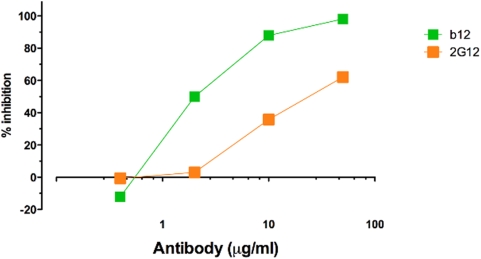
Comparison of antibody-dependent cell-mediated viral inhibition (ADCVI) by 2G12 and b12.Target cells (CEM.NKR-CCR5) were infected with SHIVSF162P3 and incubated for 48 hours, washed to remove cell-free virus and combined with Rhesus PBMC effector cells and serially diluted antibody. Viral inhibition was measured after incubation for 7 days. 2G12 is somewhat less effective than b12 in mediating ADCVI for a strict concentration comparison. An unpaired Two-tailed t test (P = 0.3285) of b12 and 2G12 ADCVI with an F test comparison of variance reveals no significant difference (P = 0.4154). Analysis performed in GraphPad Prism Software for Mac, Version 5.0a.